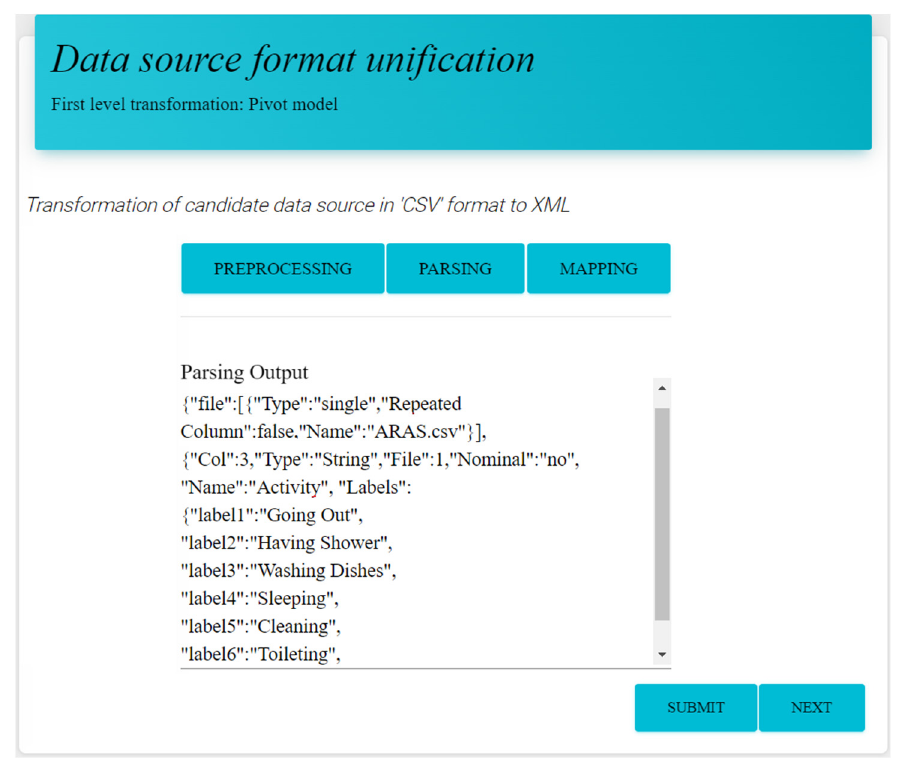
Figure 14. Data source format unification at t 2 with an example of a parsed candidate data source.